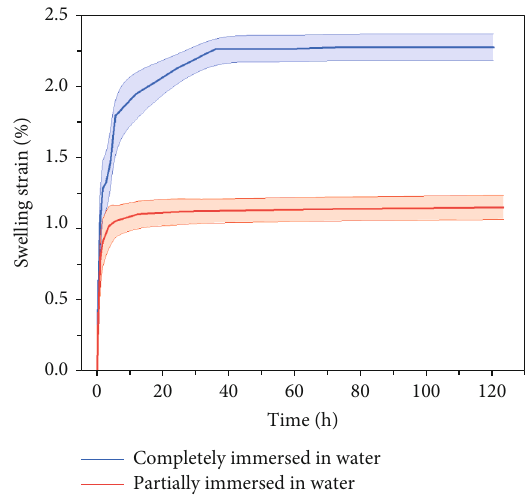
Figure 9: Comparison of swelling curves for partially and completely immersed in